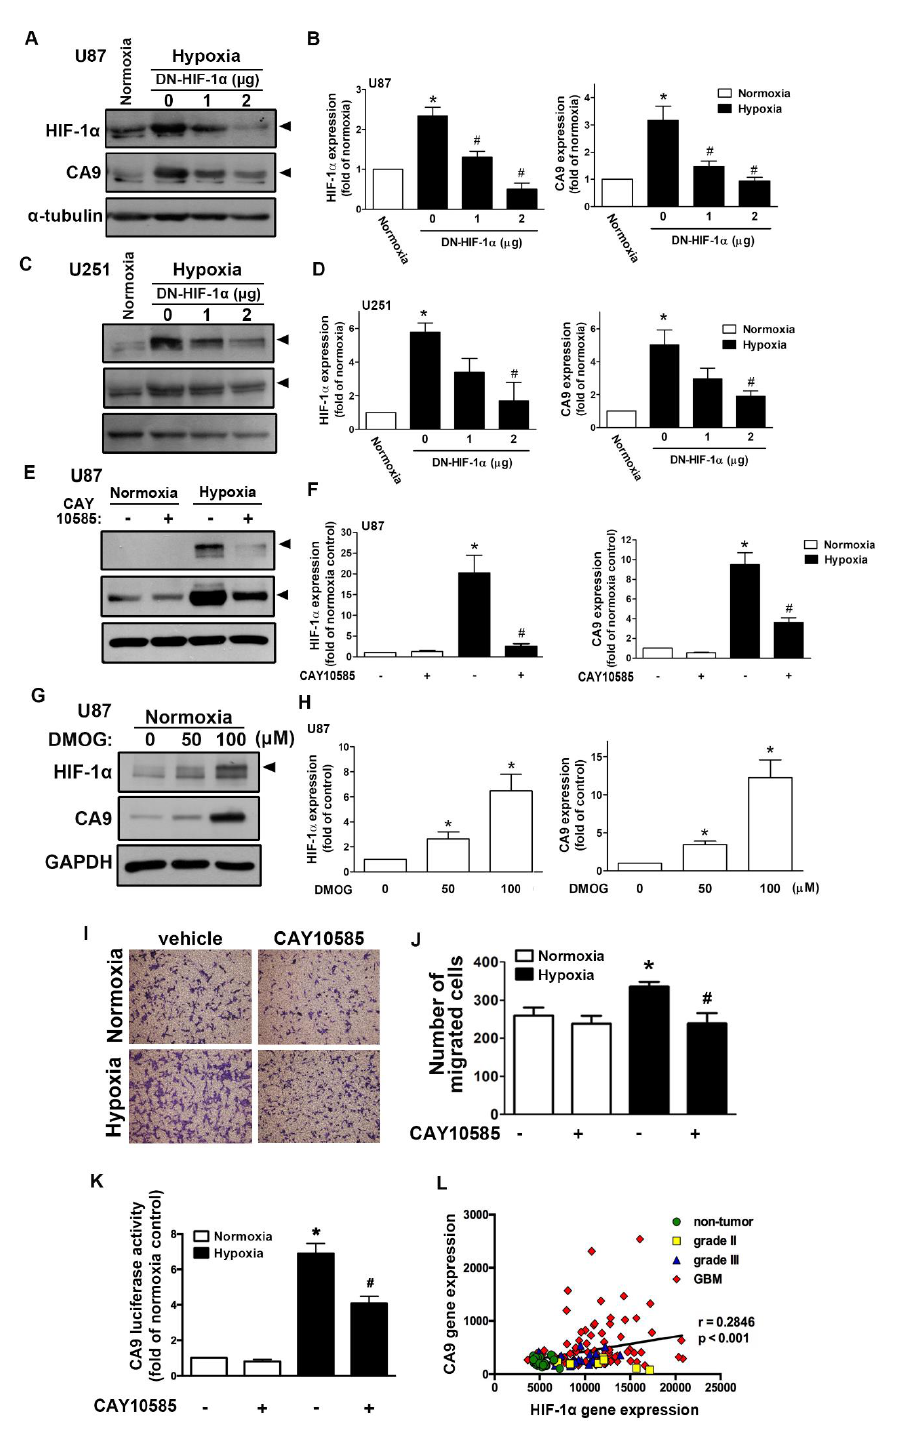
Figure 1. Hypoxia-inducible factor (HIF)-1 α is involved in the hypoxia-induced CAIX expression and glioblastomamultiforme(GBM)migration. U87( A )andU251( C